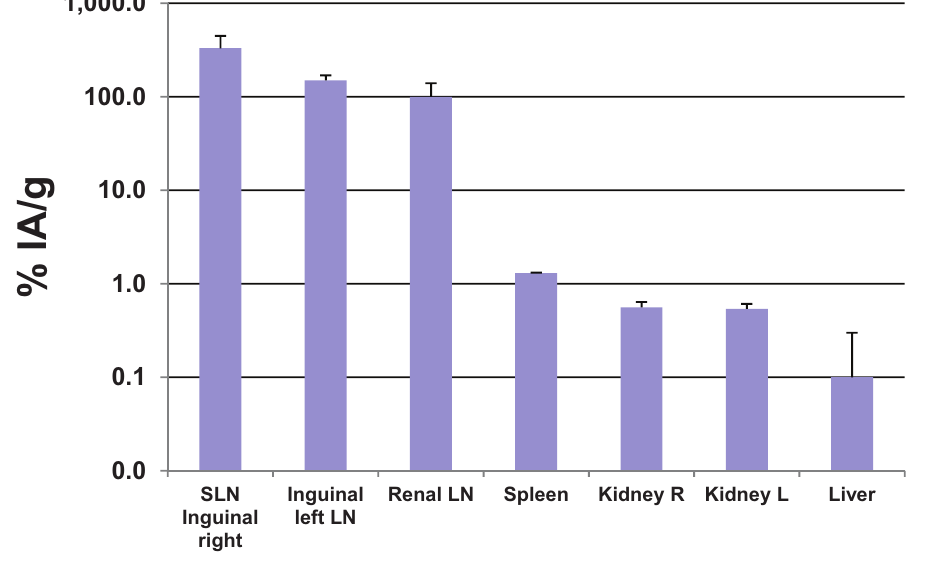
Figure 6. Biodistribution of 99m Tc-AF-SPIONs in two white Wistar rats, 5 h post injection.